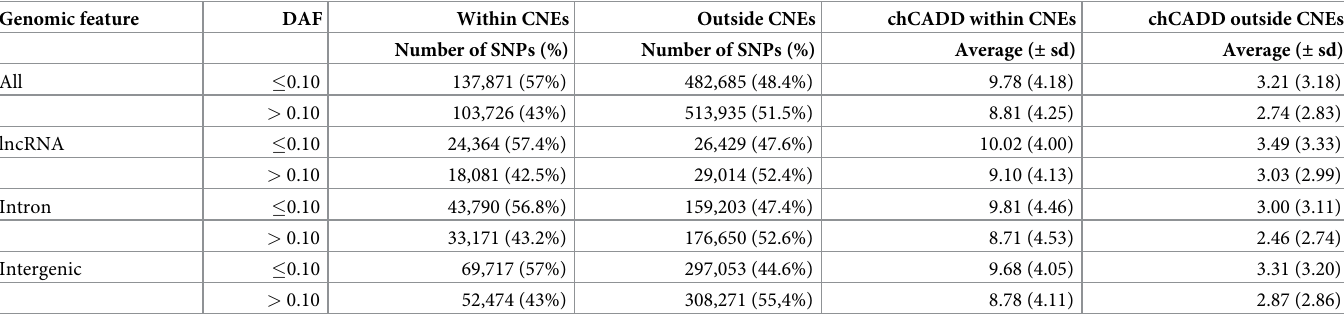
Table 2. Derived allele frequency distribution for SNPs in CNEs and non-CNEs. The derived allele frequency was compiled using the sequence of the inferred ancestor between chicken and turkey. A derived allele frequency of 10% is used as a cut-off to define rare versus common variants. Information are reported for each genomic fea- ture that make up CNEs and